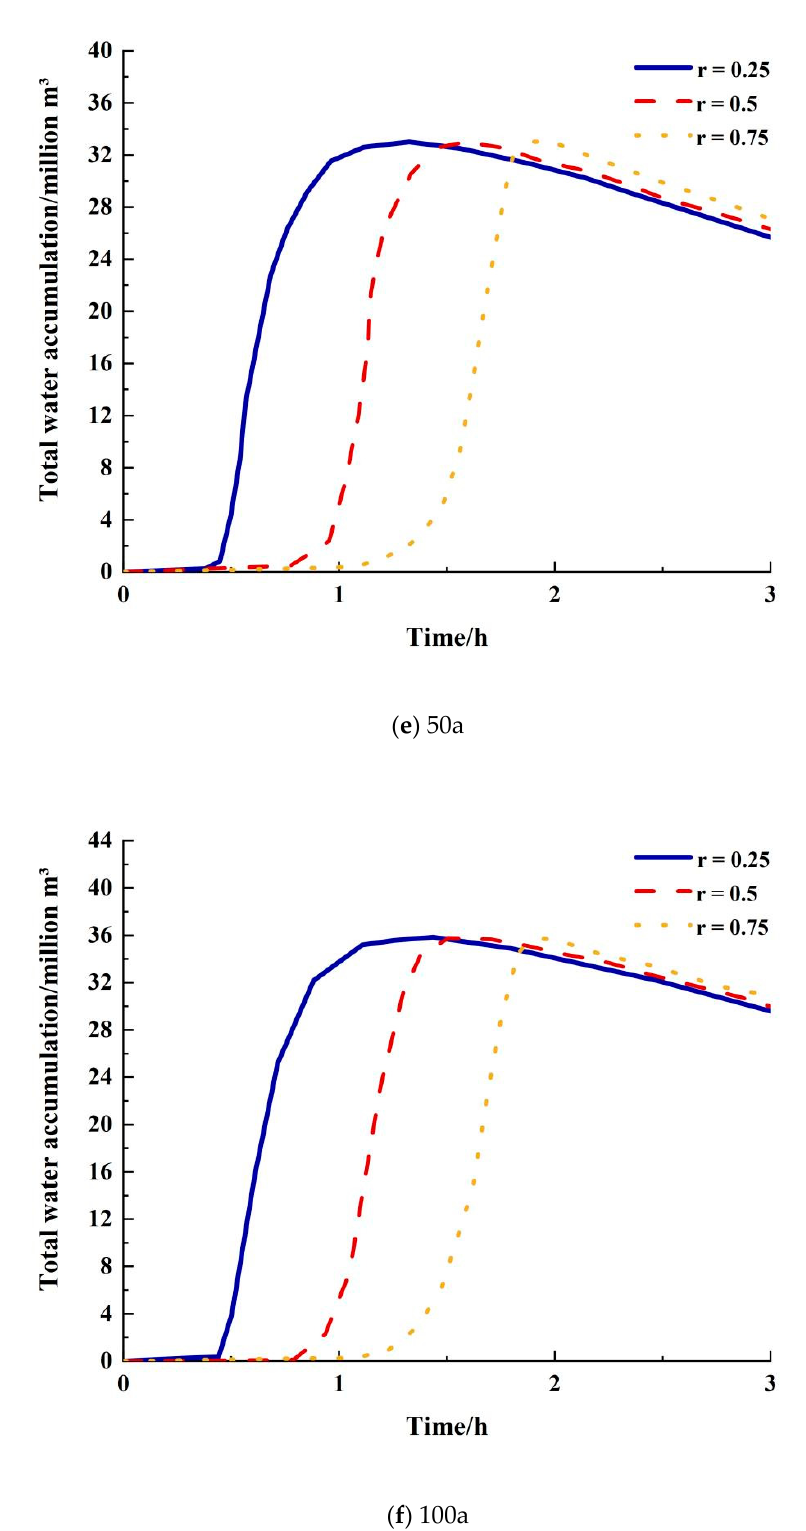
Figure 5. Variation in total water accumulation by rainfall type for different recurrence periods.